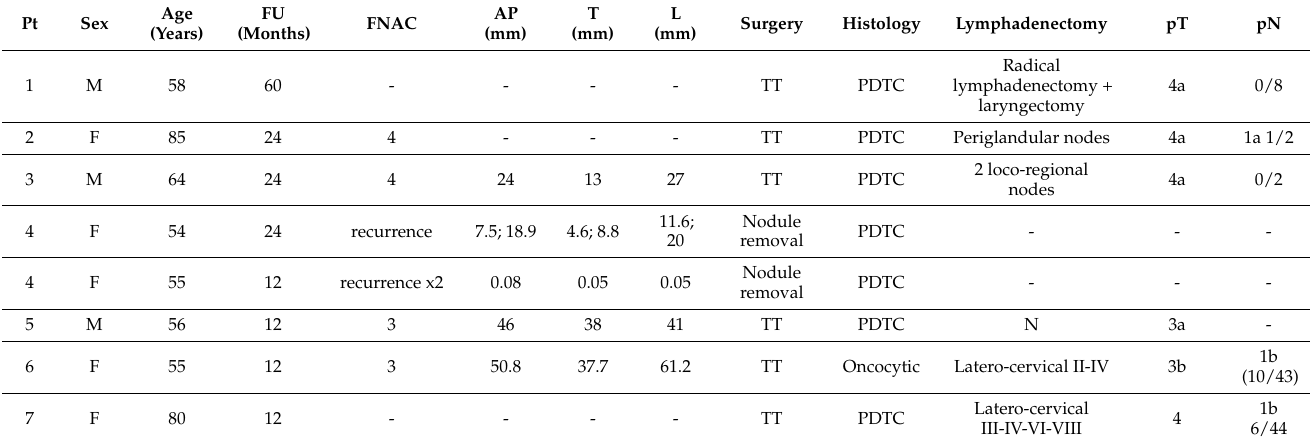
Table 4. Our single centre